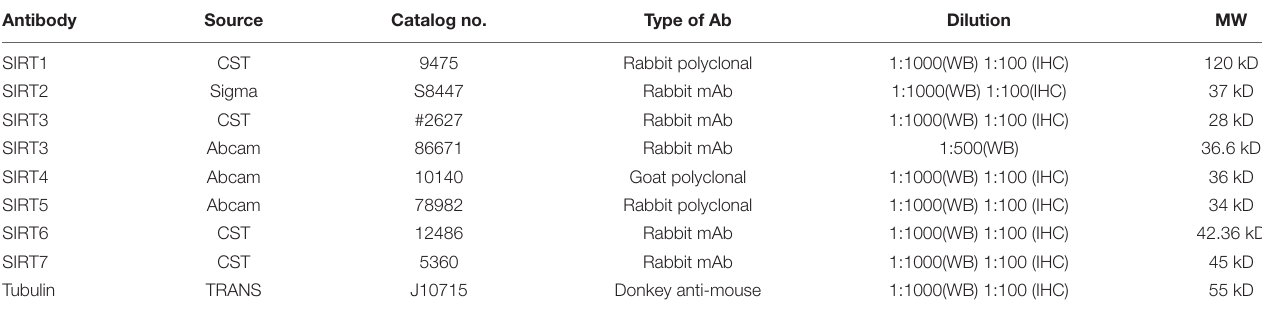
TABLE 2 | Primary antibodies used in the